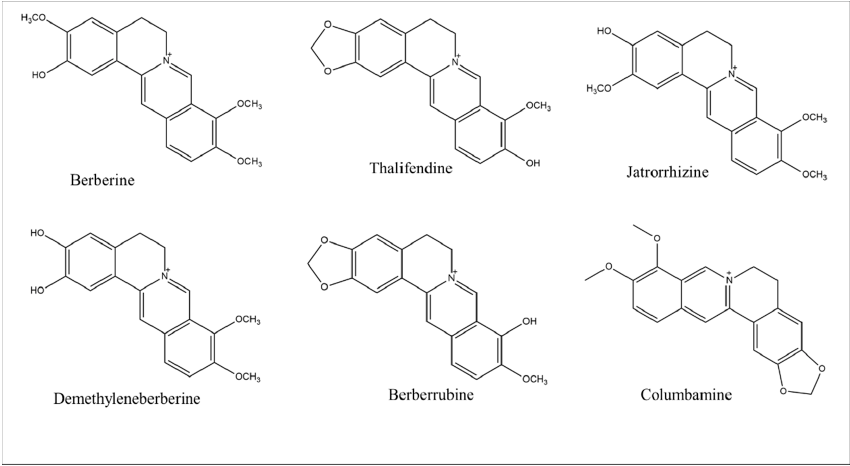
Figure 1. Chemical structure of berberine and its bioactive components. Table 1. The summary of the physicochemical properties and natural sources of berberine.